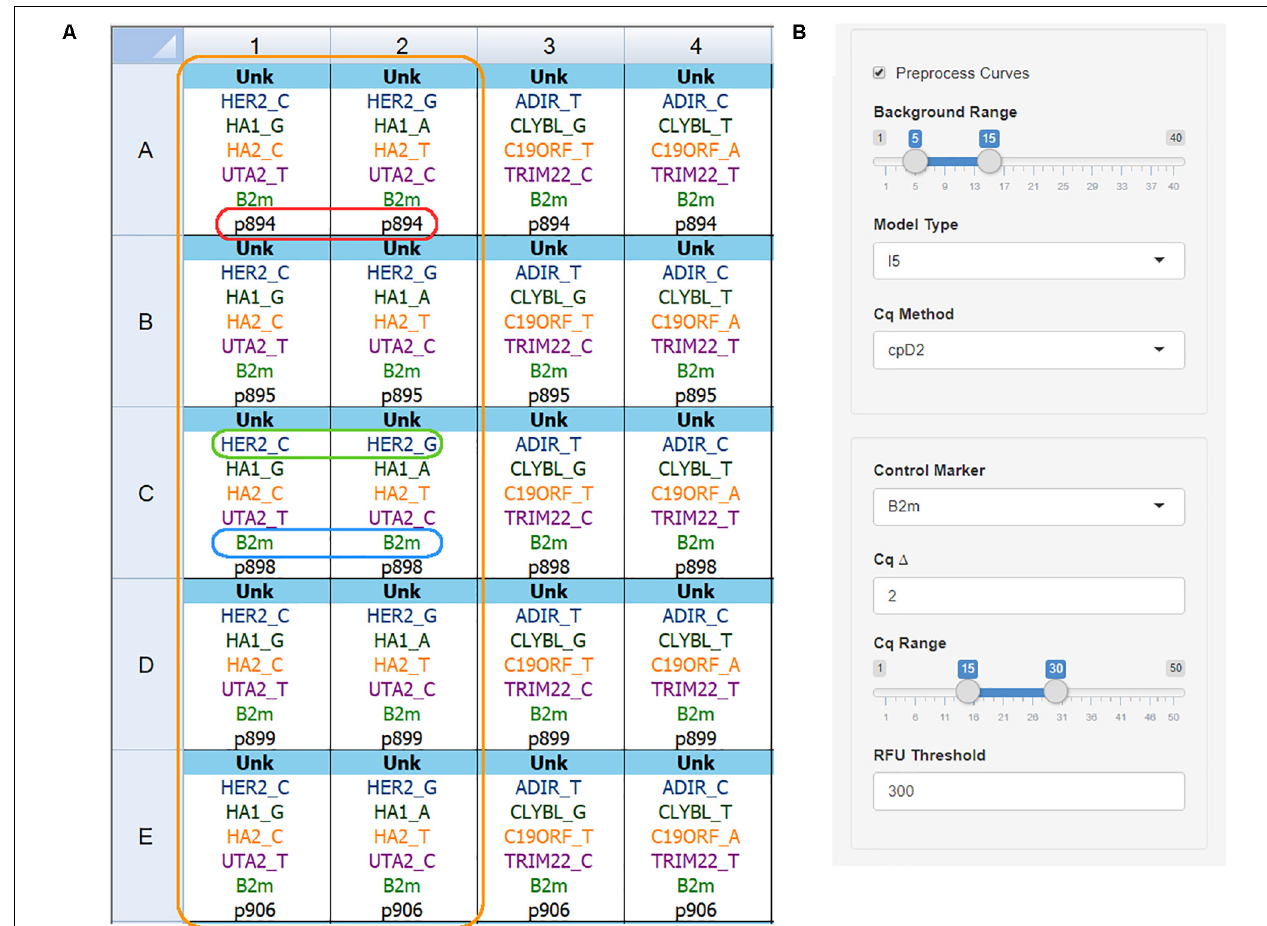
FIGURE 2 | qPCR plate setup and analysis settings. (A) Plate setup view for the Bio-Rad CFX Manager v3.1 software showing correct name convention: orange box – one primer kit set for five DNA samples; red box – sample name is the same for both wells; green box – target name and allele name are separated by the underscore sign; blue box – control gene name is the same for all wells; (B) The AScall import and preprocessing options, no amplification range, curve fitting model, Cq determination method can be set for